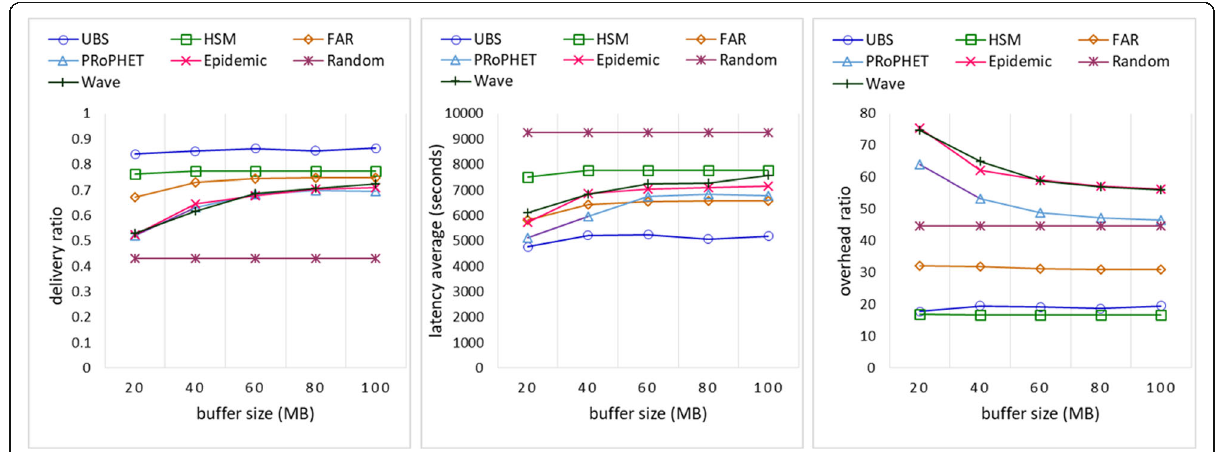
Fig. 10 The performance of schemes by varying buffer